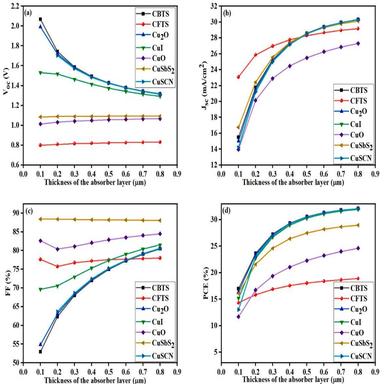
Thickness of the absorber layer versus SC performance parameters with ETL ZnSe.